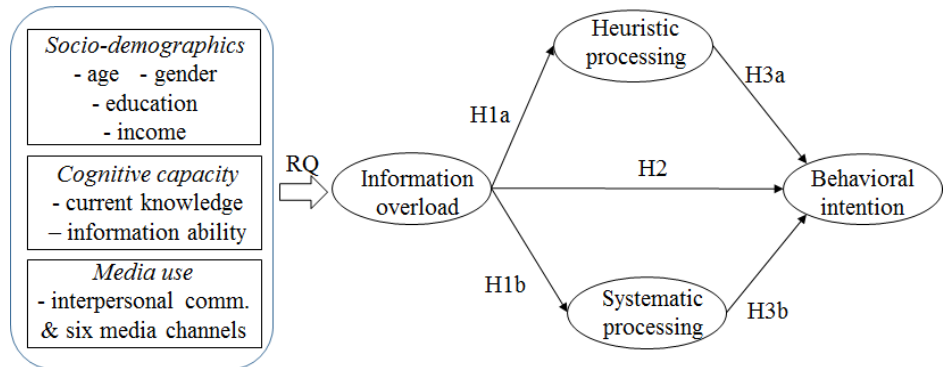
Figure 1. Research model.